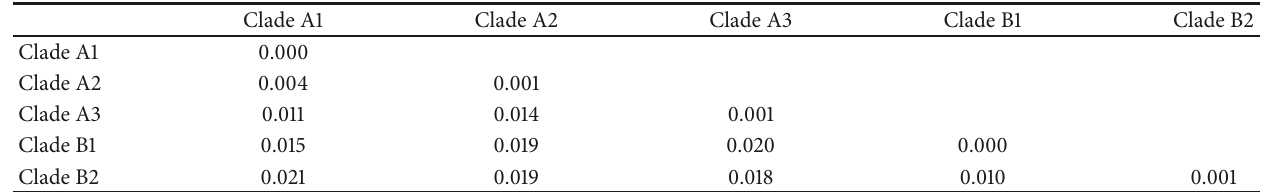
Table 1: Genetic distances between clades of Astyanax rivularis (A1, A2, and A3) and Astyanax paranae (B1 and B2). The values on the diagonal are genetic distances within each clade.